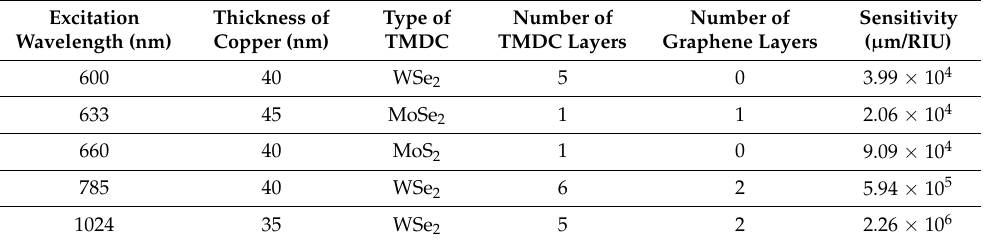
Table 3. Highest sensitivity values ( µ m/RIU) for wavelengths: 600 nm, 633 nm, 660 nm, 785 nm, and 1024